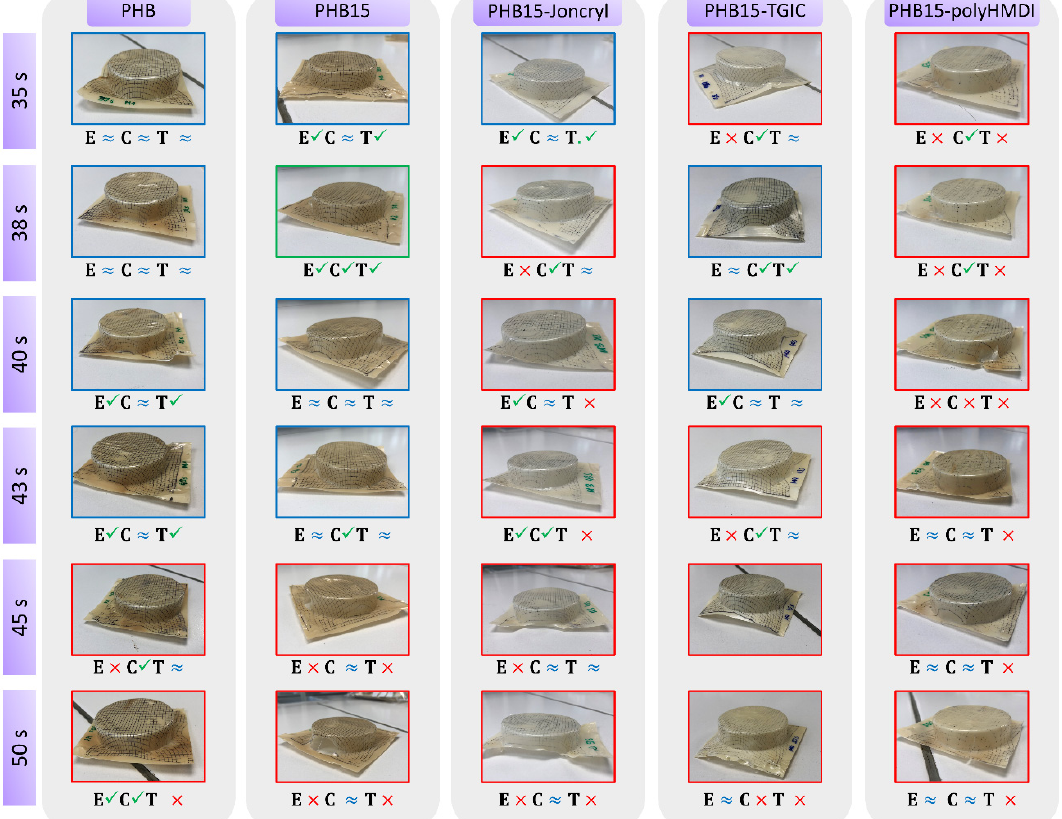
Figure 5. Photographs and assessment of thermoforming ability of the trays, showing different heating times for Neat PHB, PHBV/15TPE blend, and the PHB/15TPE compatibilized blends. The frame color indicates the overall quality of thermoforming, based upon the inspection of edges (E), corners (C) and thickness uniformity